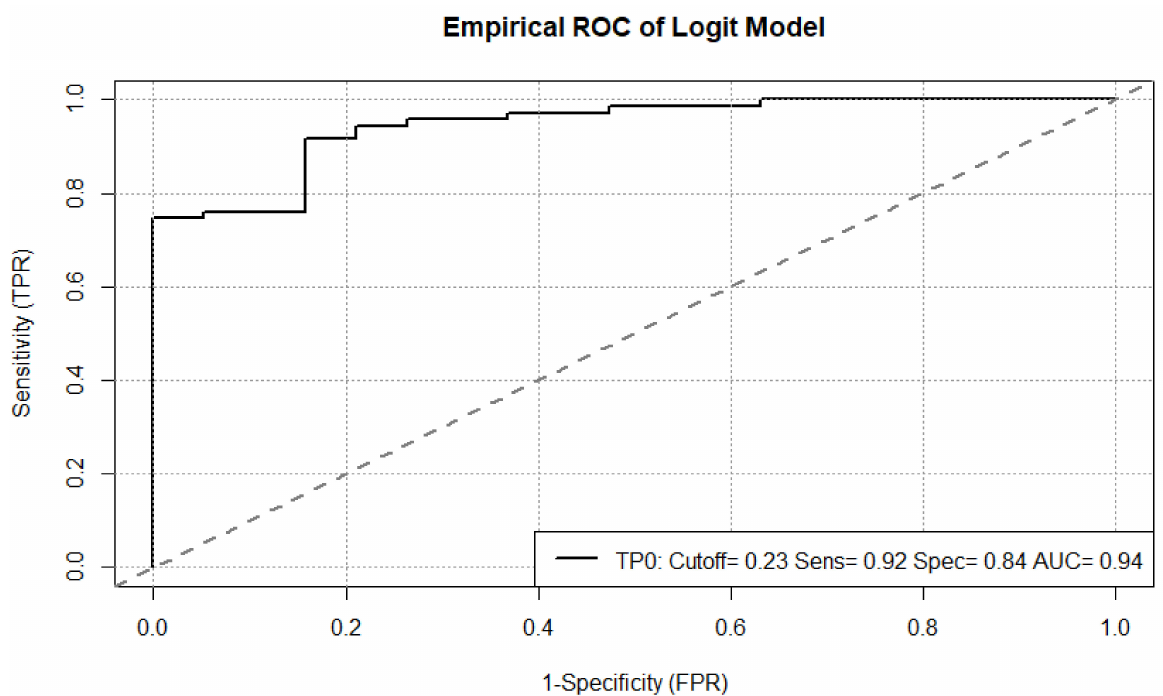
Figure 7. Receiver operating characteristic ROC of our backward regression model for outcome prediction in metastatic melanoma patients six months after initiation of